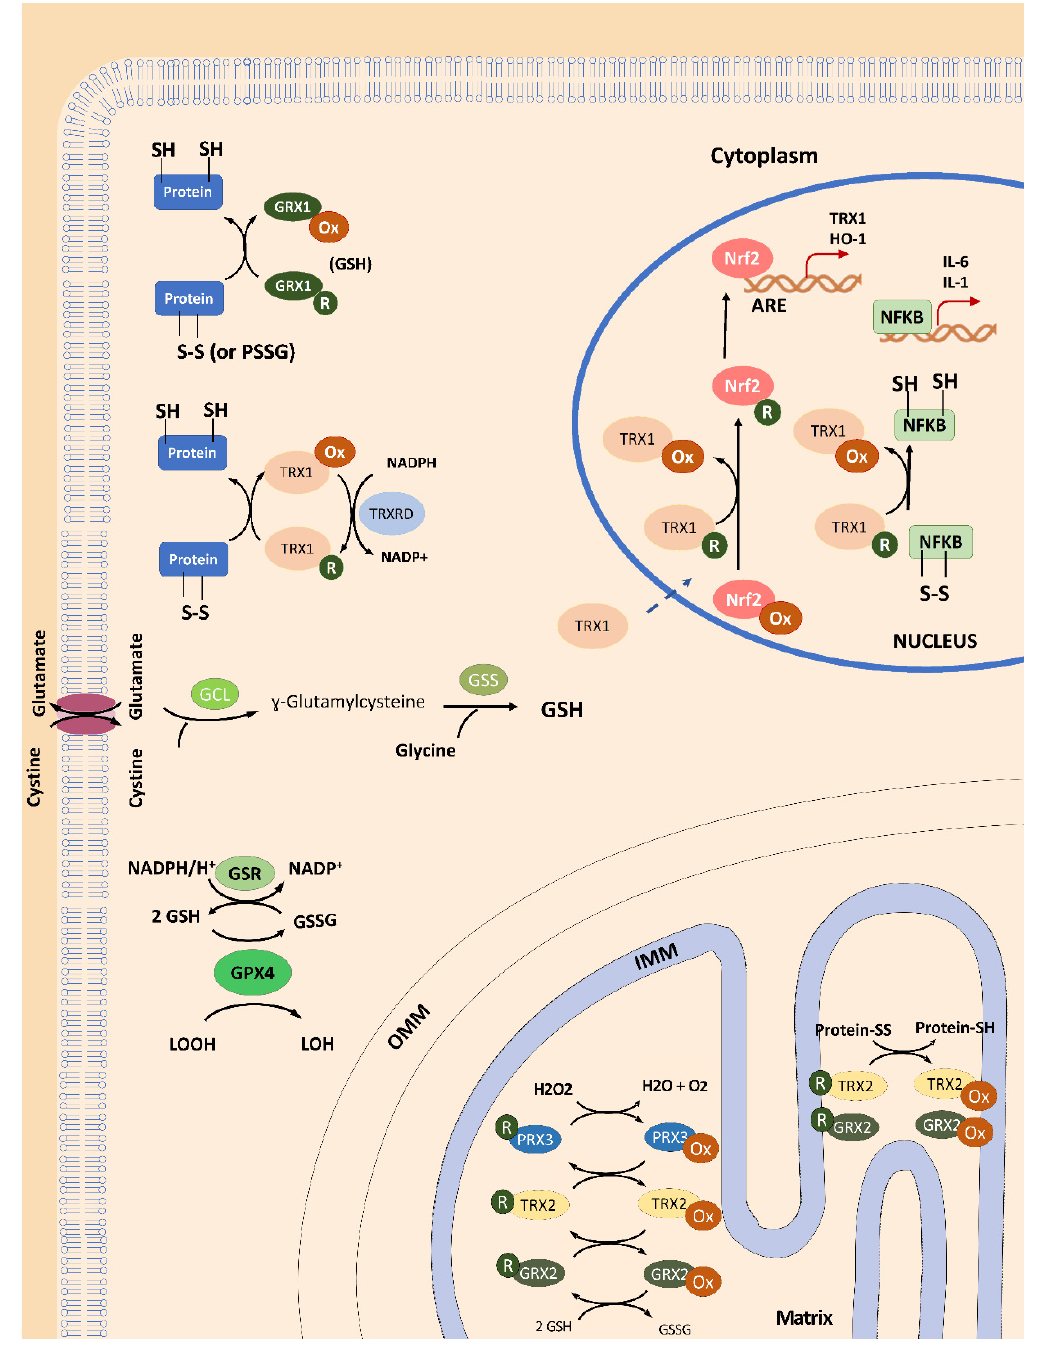
Figure 1. General overview of TRX and GLRX functions in mammalian cells. In the cytosol, glutaredoxins (GLRX1) can reduce protein dithiols through a di-thiol and mono-thiol mechanism or reduce S-glutathionylated proteins (PSSG) in a gluthation (GSH)-dependent process during its activity as disulfide oxireductase. Thioredoxin 1 (TRX1) also acts as dithiol reductase, maintaining the redox homeostasis of the proteins. The reduced form of TRX1 is re-established by thioredoxin reductase 1 (TRXRD1), which uses the electrons from nicotinamide adenine dinucleotide phosphate (NADPH). The NADPH is also important to provide electrons to glutathione reductase (GRX) which can recover the levels of reduced gluthation (GSH) from oxidized form (GSSG), and then be used as cofactor of glutathione peroxidase 4 (GPX4) to reduce lipoperoxides. The reduced form of TRX1 can be translocated to the nucleus and interact with nuclear factor- κ B (NF- κ B) and activator protein 1 (AP-1) to regulate gene expression. The translocation of the transcription factor NRF2 to the nucleus depends on the cytosolic levels of GSH (which controls the interaction between NRF2 and its modulator Kelch-like ECH-associated protein 1 (Keap1)) and the nuclear TRX1 (which promotes